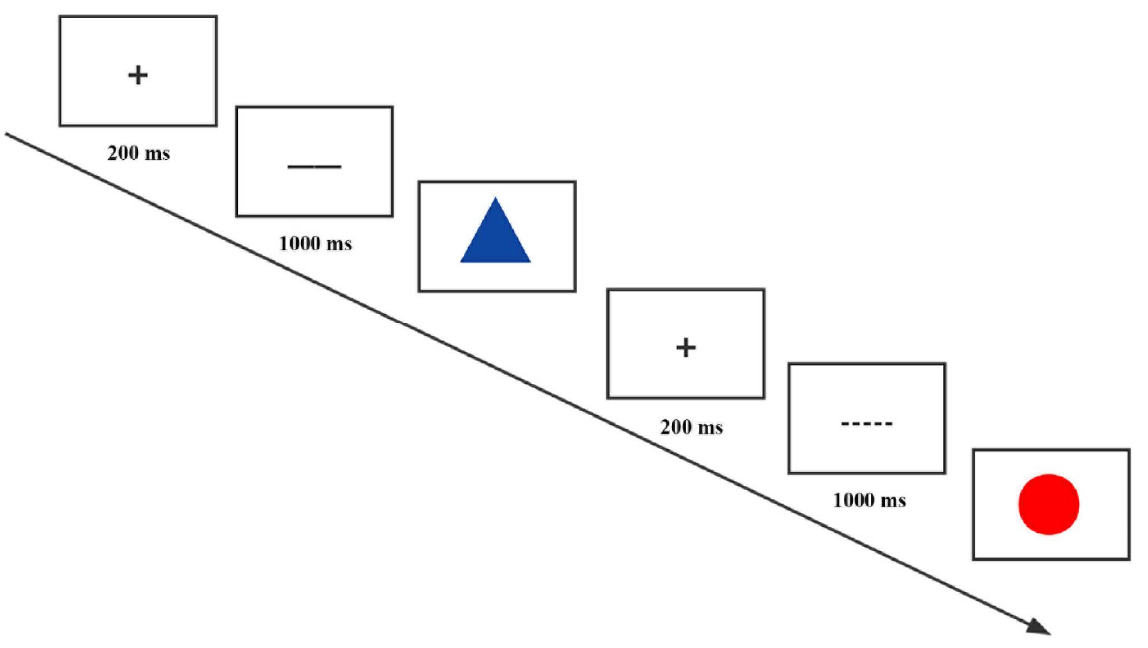
Figure 2. Flow chart of task switching paradigm. A “+” fixation was presented in the center of the computer screen for a duration of 200 ms, followed by a 1000 ms cue trail and a target stimulus presentation. The target stimulus had no time limit, and participants’ responses will be recorded.